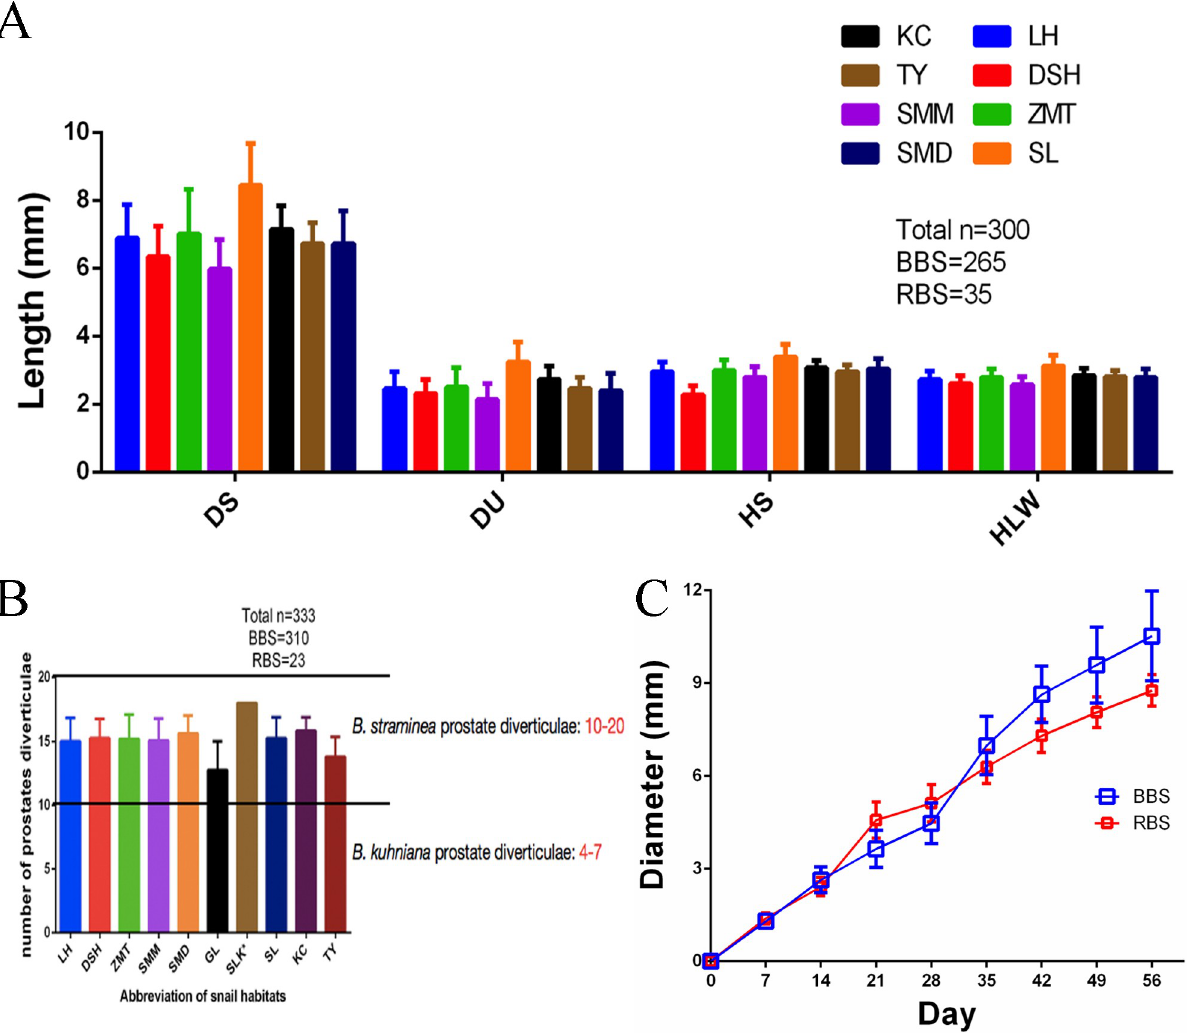
Fig 6. Biological features of BBS and RBS. ( A ) Configuration and size of wild Biomphalaria snails. ( B ) Prostate diverticula of field-captured Biomphalaria snails. ( C ) Growth rates between BBS and RBS reared in